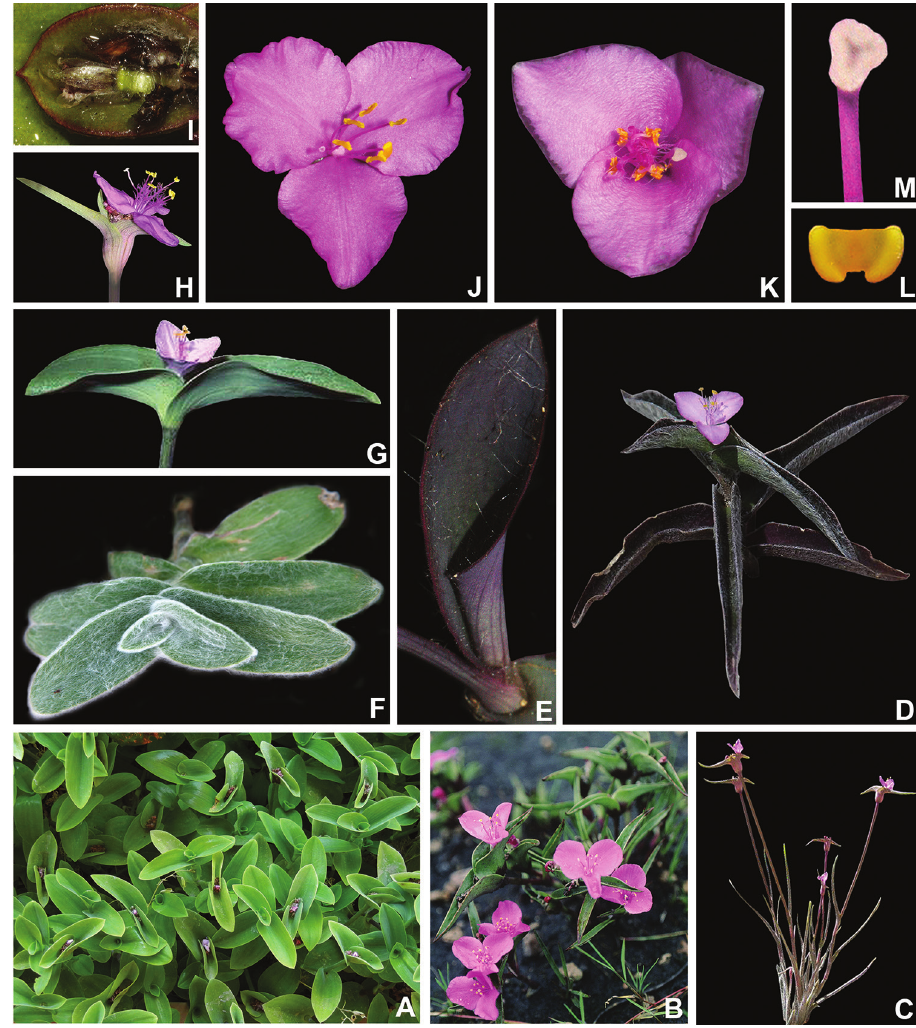
Figure 13. Tradescantia subg. Setcreasea (K.Schum. & Sydow) M.Pell. A–D habit: A prostrate habit with ascending apex to T. buckleyi (I.M.Johnst.) D.R.Hunt B the dwarf habit of T. pygmaea D.R.Hunt C erect habit of T. hirta D.R.Hunt D habit of T. rozynskii Matuda, showing the spirally-alternate and strongly complicate leaves E–F leaves: E young leaf of T. pallida (Rose) D.R.Hunt cv. Purpurea , show- ing the glabrous leaves with lanate hairs at the margin F branch of T. sillamontana Matuda, showing the distichously-alternate leaves, densely covered by lanate hairs G–H inflorescence: G main florescence of T. brevifolia H inflorescence of T. hirta I post-anthesis flower of T. sillamontana , showing the hyaline sepals. J–K flowers: J front view of a flower of T. sillamonata K front view of a flower of T. pallida L anther of T. pallida , showing the quadrangular connective and C-shaped anther sacs M style of T. pallida , showing the trilobate stigma. A by J.M. Jenkins, B by M. Egger, C by J.-P. Piquet, D by J. Vích, E, I–M by M.O.O. Pellegrini, F by D. Stang, G by K. Yatskievych, and H by O.